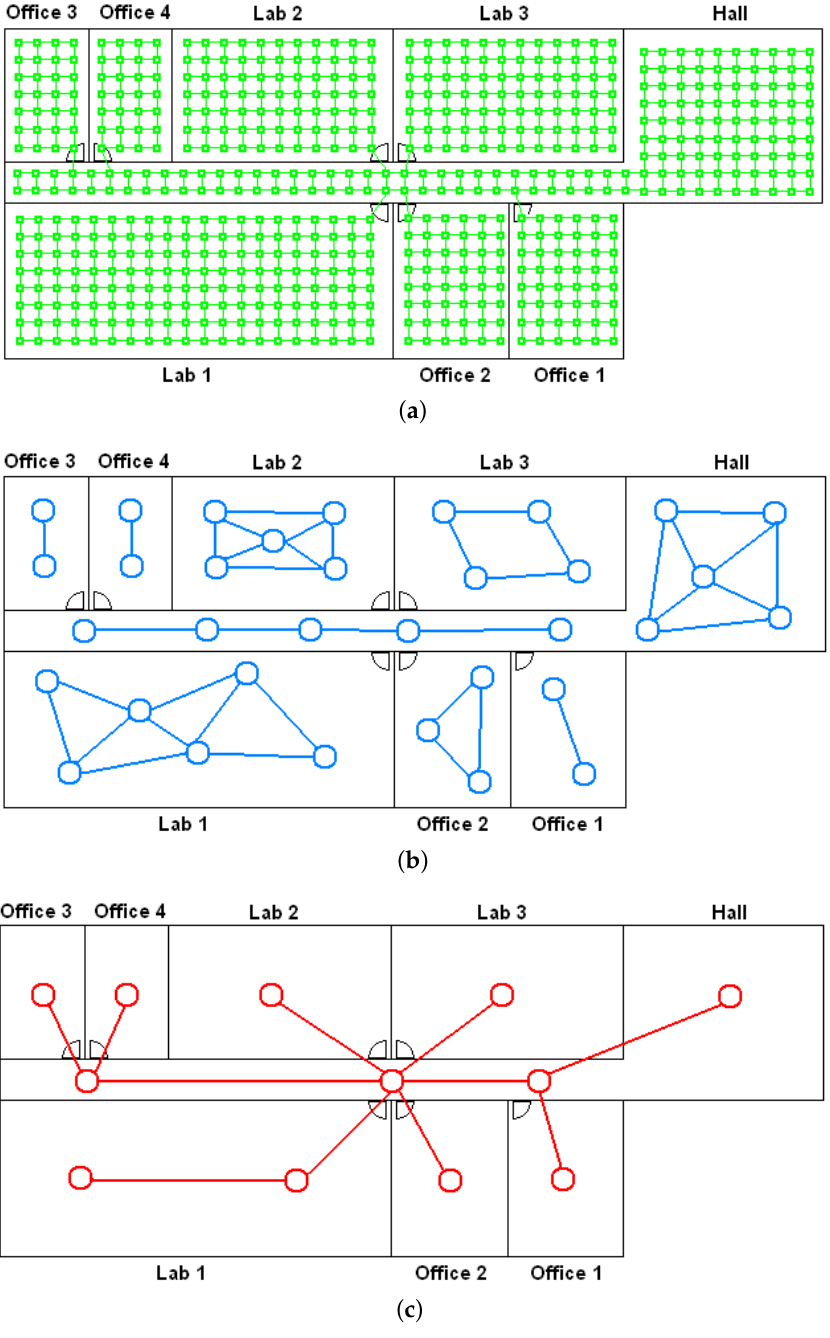
Figure 1. Hierarchical topological map built from a set of scenes captured from several rooms of a sample environment. ( a ) Low-level; ( b ) intermediate-level; and ( c ) high-level